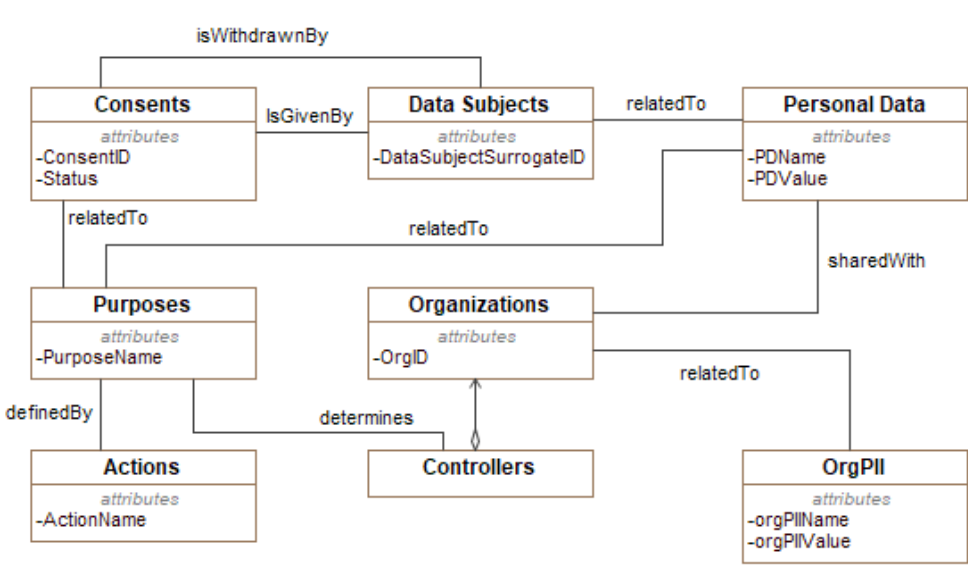
Figure 8. CaPe’s Consent Model: An Extract (Adopted from